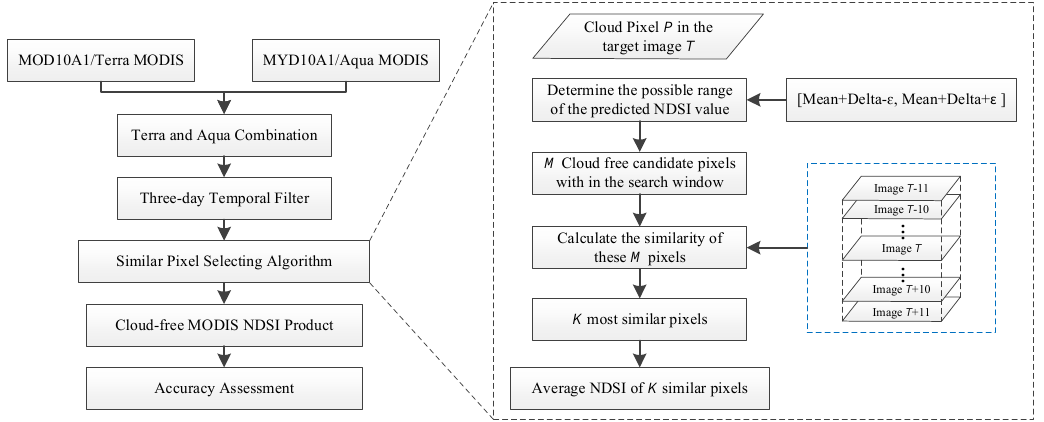
Figure 3. Schematic of the Moderate Resolution Imaging Spectroradiometer(MODIS) daily NDSI products gap-filling procedure.